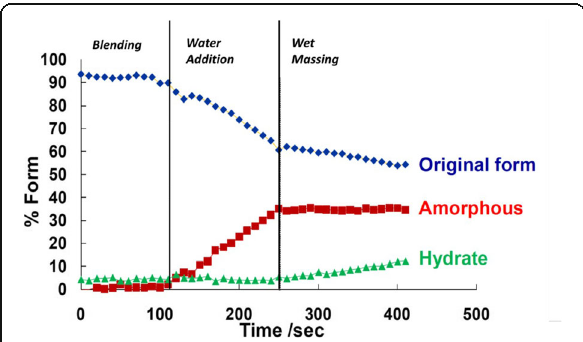
Fig. 6 Monitoring the kinetics of transformation during processing using Raman spectroscopy (adapted from S. Nicholson, June